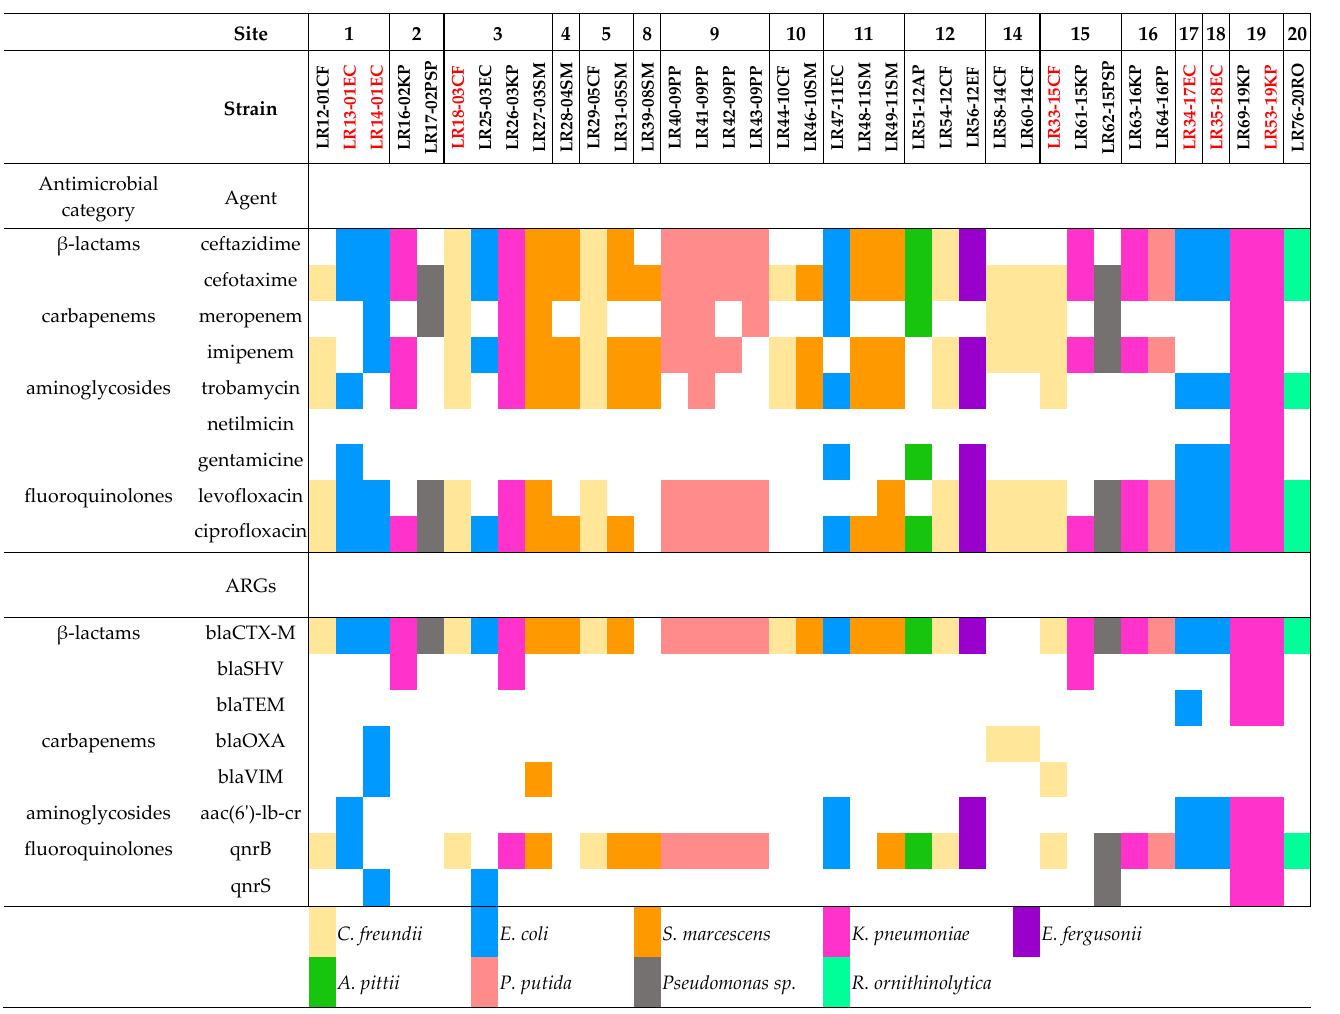
Table 1. Multidrug resistance strains and resistance genes identified among the isolates. The strains in red were the ones selected for WGS.